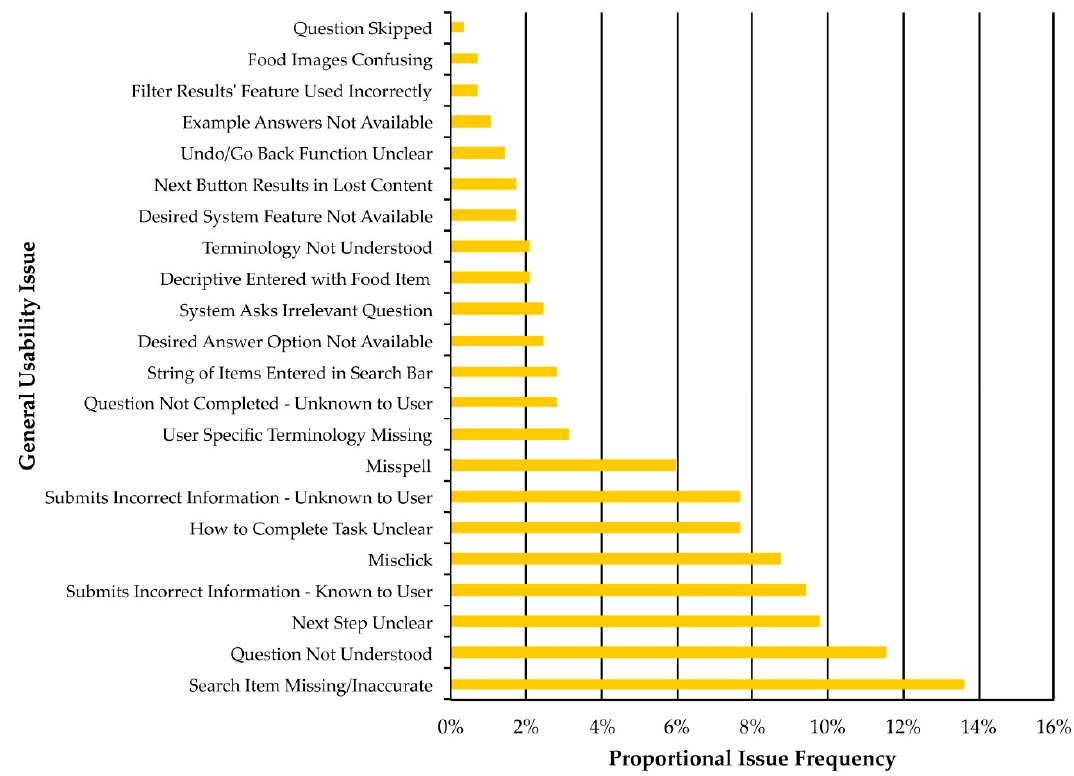
Figure 5. Proportional frequency (%) of each general usability issue across all ASA24 tasks for participants in the moderated ( n = 10) and semi-moderated ( n = 11) groups.